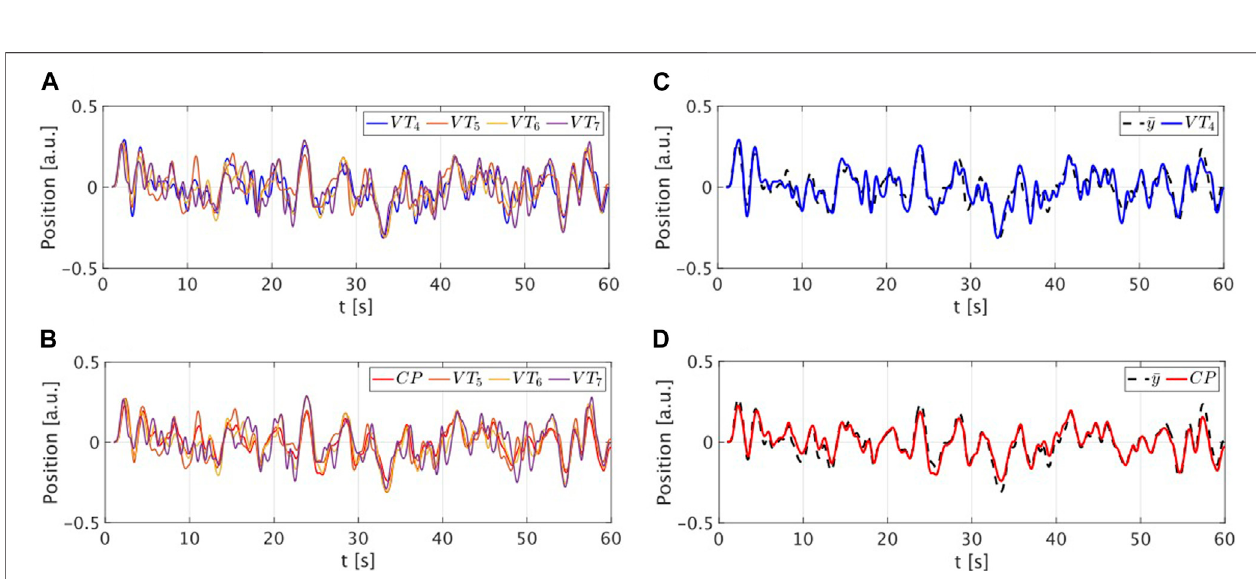
FIGURE2| Training curveshowingtheconvergenceofthealgorithm.Theroot meansquare errorinposition( y -axis)isreportedforeach trial ( x -axis)bothbetween the target VT 4 (in blue) and (A) VT 1 , (B) VT 2 , (C) VT 3 , and between the CP (in red) and the same players.